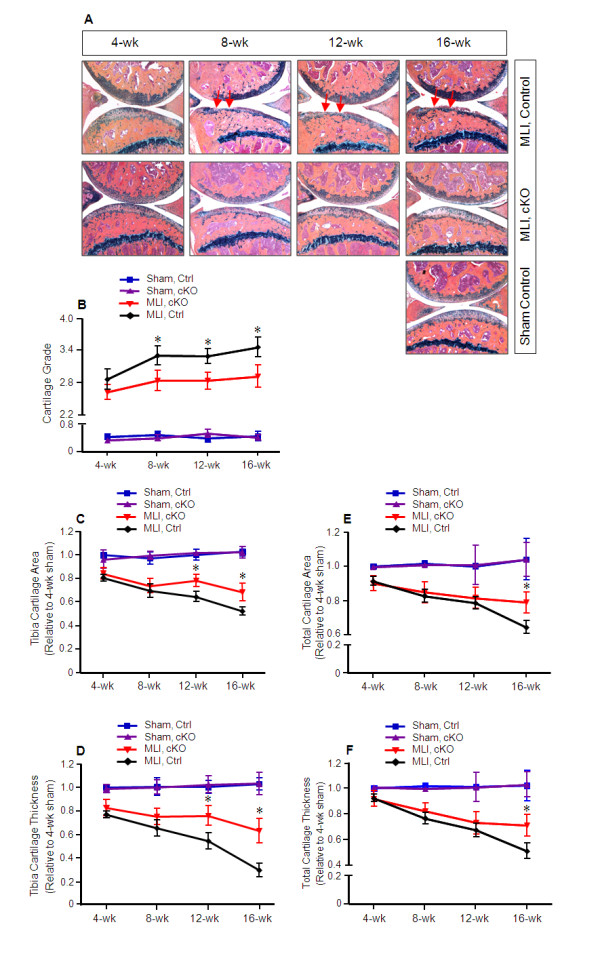
Decelerated osteoarthritis progression in Mmp13Col2ER mice. Tamoxifen was administered when matrix metalloproteinase (MMP13) conditional knockout (cKO) mice (Mmp13Col2ER) and Cre-negative control mice were two weeks old (1 mg/10 g body weight, i.p., daily for five days). Meniscal-ligamentous injury (MLI)-induced osteoarthritis (OA) surgery was performed on the right hind-limbs when the mice were 10 weeks old. The left hind-limbs were used as sham controls. (A) Knee joint samples were harvested 4, 8, 12, or 16 weeks post-surgery and Alcian blue/Hematoxylin/Orange G staining was performed. Histological results showed decreased articular cartilage degradation in Mmp13Col2ER mice 8, 12 and 16 weeks post-surgery. (B) Histological grading by blinded observers confirmed decreased articular cartilage degradation in Mmp13Col2ER mice at 8, 12, and 16 weeks compared to control Cre-negative mice (*P < 0.05). (C) Tibia articular cartilage area was quantified by tracing the Alcian blue-positive area in the proximal tibia. There was no significant difference 4 and 8 weeks post-surgery in Mmp13Col2ER MLI mice versus control MLI mice. The tibia cartilage area was increased 21% in Mmp13Col2ER MLI mice compared to control MLI mice 12 weeks post-surgery (*P < 0.05) and increased 31% 16 weeks post-surgery (*P < 0.05). (D) Tibia thickness was quantified by tracing the Alcian blue-positive thickness in the center of the tibial plateau. There was no significant difference in tibial cartilage thickness at 4 or 8 weeks post-surgery. Tibia cartilage thickness was increased 29% in Mmp13Col2ER MLI mice compared to control MLI mice 12 weeks post-surgery (*P < 0.05) and increased 50% 16 weeks post-surgery (*P < 0.01). (E) Total articular cartilage area was quantified by tracing the Alcian blue-positive area in both the proximal tibia and distal femur. No significant differences were detected 4, 8, and 12 weeks post-surgery. Total cartilage area increased 18% in Mmp13Col2ER MLI mice compared to control MLI mice 16 weeks post-surgery (*P < 0.01). (F) Total cartilage thickness was quantified by tracing the Alcian blue-positive thickness in the center of the proximal tibia and distal femur. No significant differences were detected at 4, 8, and 12 weeks post-surgery. Total cartilage thickness increased 39% in Mmp13Col2ER MLI mice compared to control MLI mice 16 weeks post-surgery (*P < 0.01).